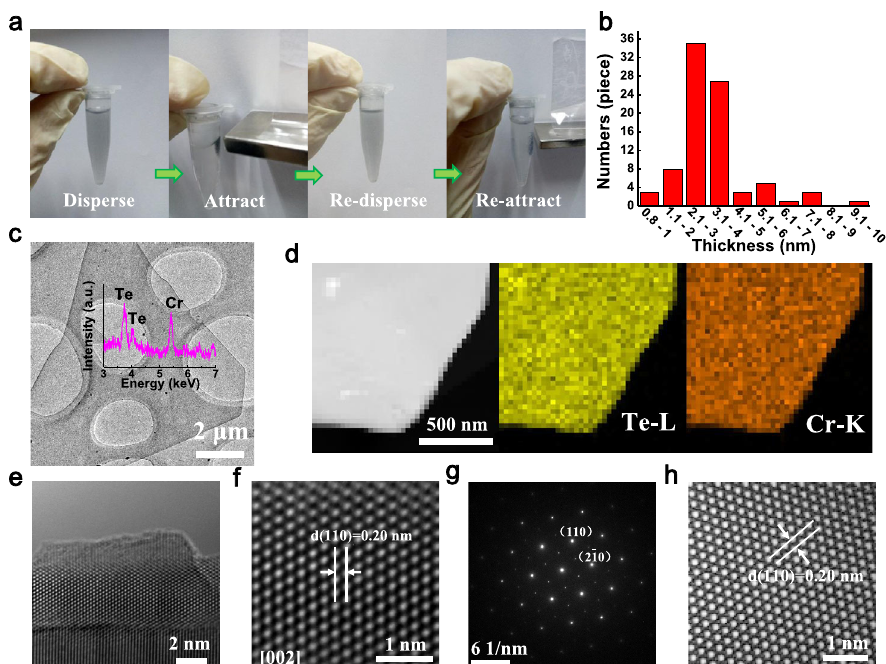
Fig. 2 Characterization of freestanding few-UC 2D CrTe crystals. a Freestanding few-UC CrTe crystals are well dispersed in ethanol, attracted by a ferromagnet and well re-dispersed after attraction. b Thickness distribution of the freestanding few-UC CrTe crystals from AFM statistical analysis. c Micrometer-scale TEM image of the few-UC CrTe crystals on milliporous substrate. d Dark- fi eld image and corresponding element mappings for the few- UC CrTe crystal. e HRTEM image at the edge of the few-UC CrTe crystal. f Atomic-resolution TEM image of the few-UC CrTe crystal. g The selected-area electron diffraction (SAED) for the few-UC CrTe crystal. h Reduced fast Fourier transformation (RFFT) image derived from ( g